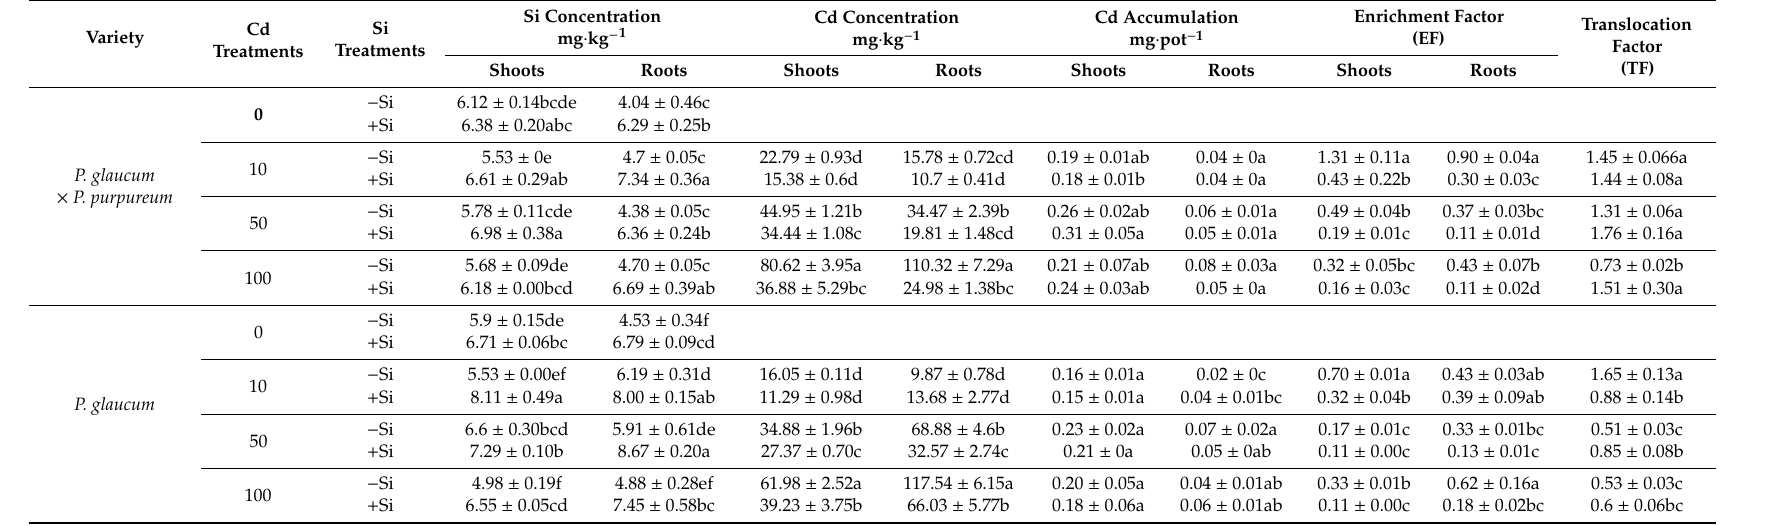
Table 2. Cd enrichment of Pennisetum with / without